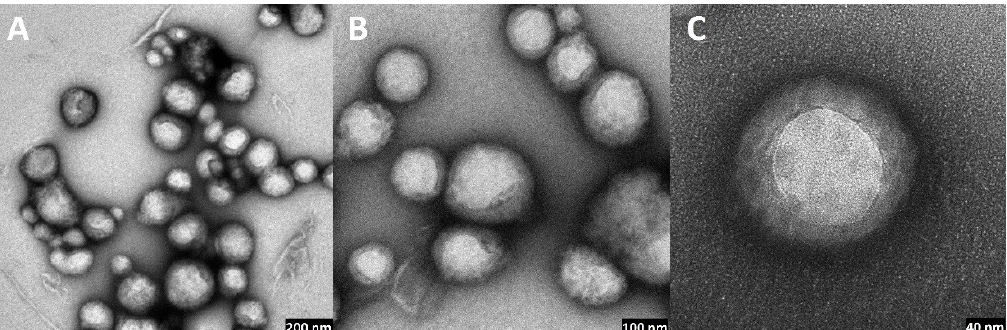
Figure 11. TEM images of bare UA-loaded PLGA nanoparticles: ( A ): magnitude 40 k, scale bar 200 nm; ( B ): magnitude 80 k, scale bar 100 nm; ( C ): magnitude 200 k, scale bar 40 nm.